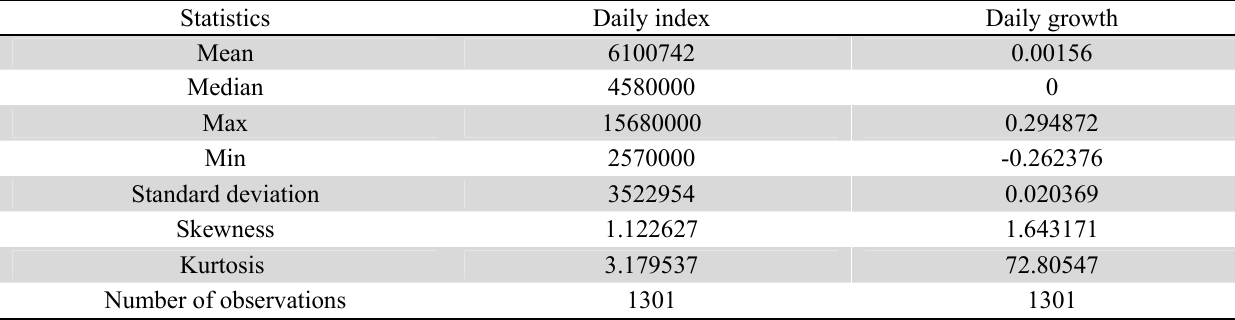
The summary of some basic statistics on gold price